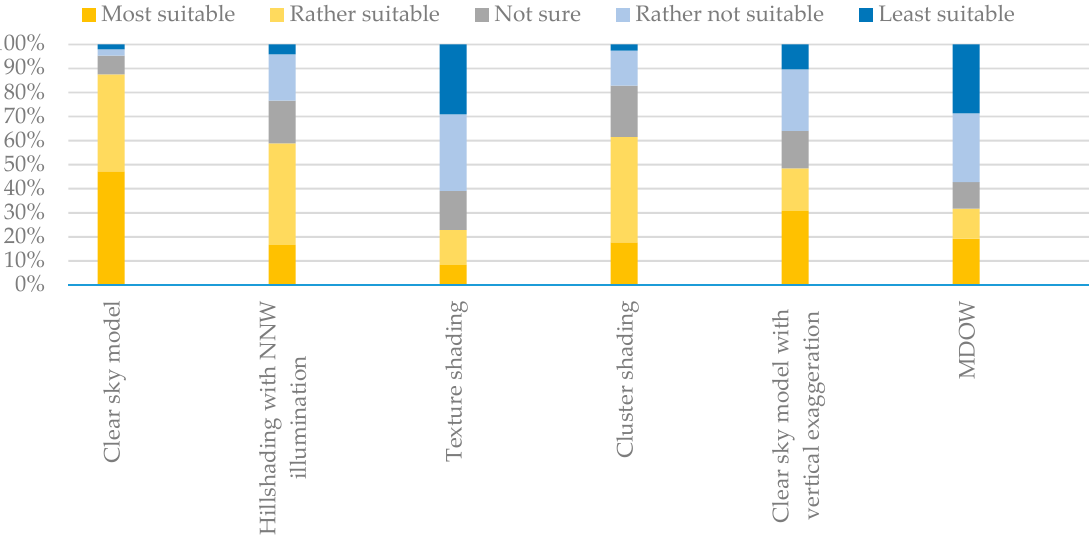
Figure 7. Survey results for block mountains.